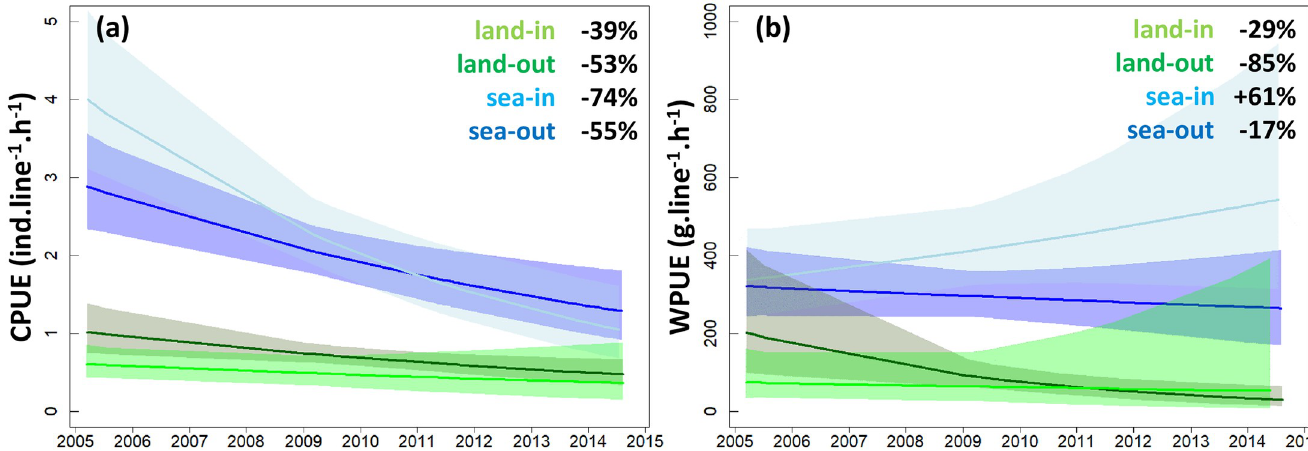
Fig 3. Trends in catch per unit effort (CPUE, a) and weight per unit effort (WPUE, b) of recreational fishermen fishing from land along the coastline (land) vs at sea from boats (sea), and inside (in) vs outside (out) the Cerb è re-Banyuls marine reserve. Curves represent mean trajectories estimated by generalized linear models and shadings indicate 95% confidence intervals. The percent changes in mean CPUE and WPUE between the beginning and the end of the study period are provided as text on the plots. See S4 Table for mean and confidence interval values. Refer to S5 Table for parameter estimates.